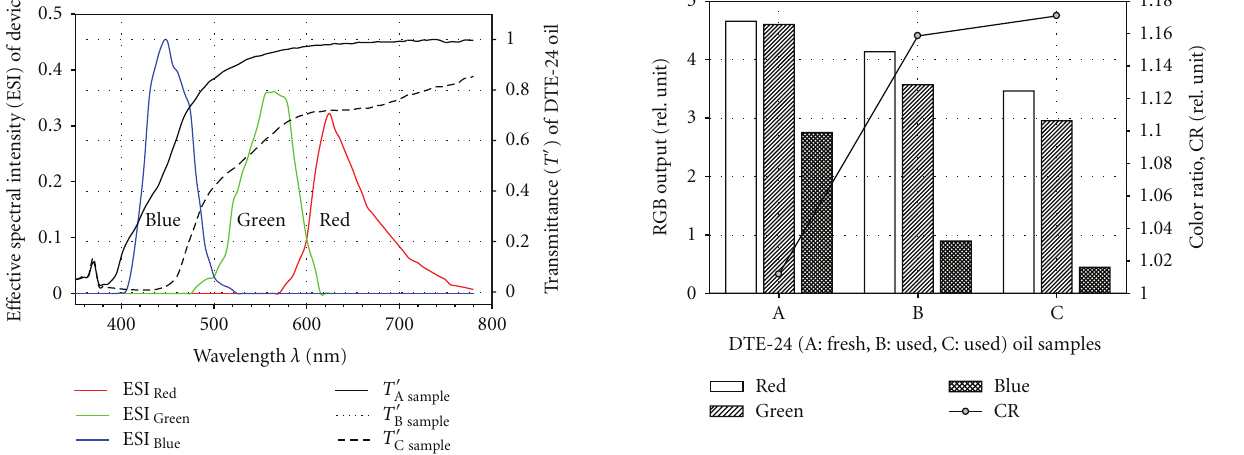
Figure 6: Device output in RGB waveband and color ratio (CR) in DTE24 #1 calibration oil.